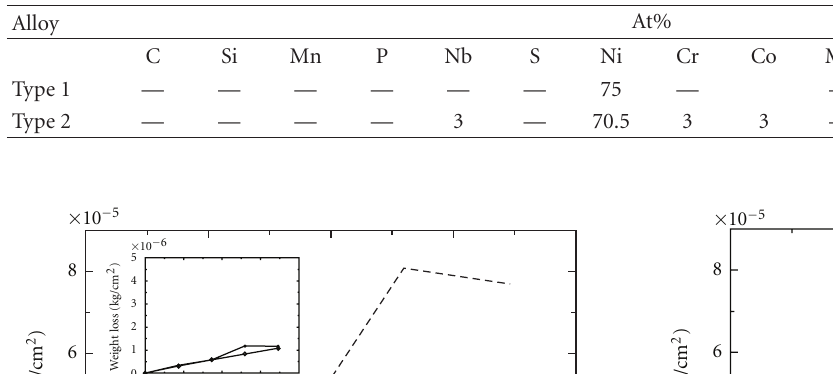
Table 1: Chemical compositions of the materials investigated.